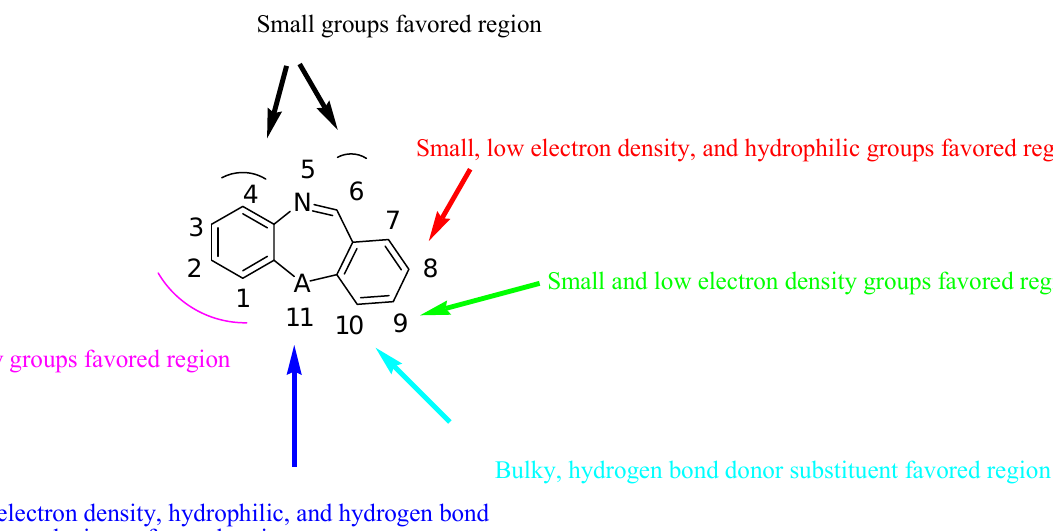
Figure 11. Common substructure used for